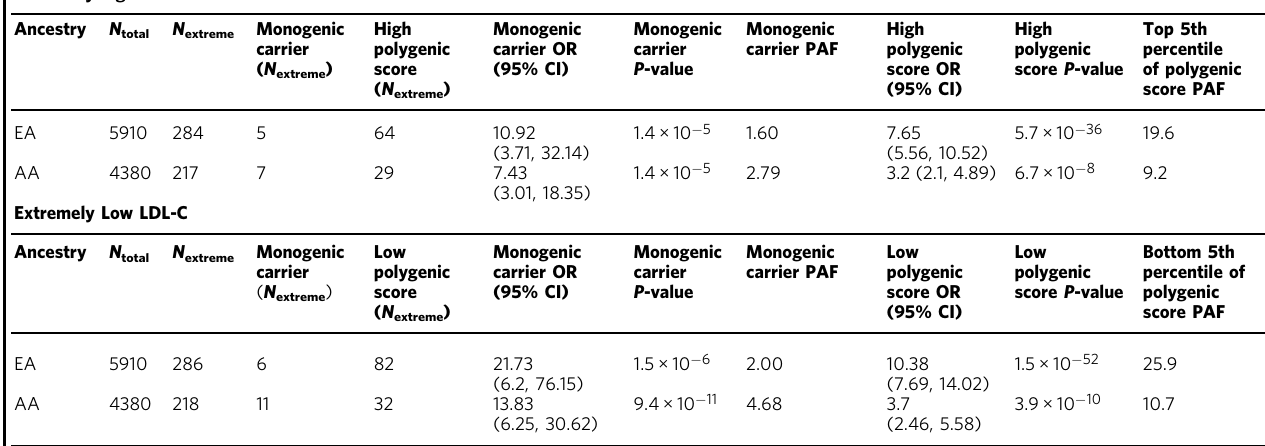
Values are represented as OR [95% CI] for association with given trait. (b). Effect of monogenic mutation or polygenic score on LDL-C in mg/dl. Values are represented as beta [95% CI] in mg/dl for LDL-C. Multi-variable associations were performed with sex + age + age 2 (effects not listed) with monogenic carrier status + high polygenic score using logistic regression. Polygenic risk score was derived from 2 million variants using LDpred. High polygenic score was de fi ned as membership in the top 5th percentile of the ancestry-speci fi c score distribution. AA, African American; EA, European American; SE, standard error.